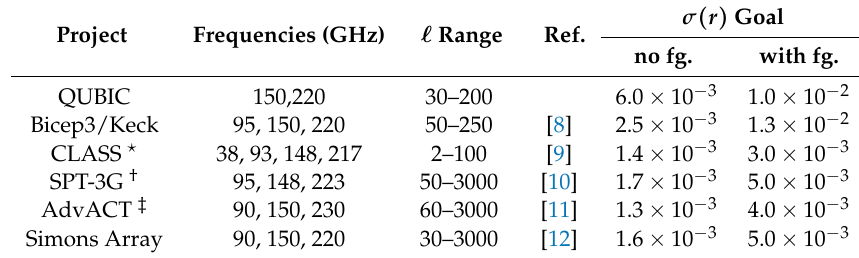
Table 1. Summary of the main B -mode ground experiments operating in a frequency range similar to QUBIC. The label “fg” or “no fg” corresponds to the assumption on the foregrounds; numbers have been extracted from